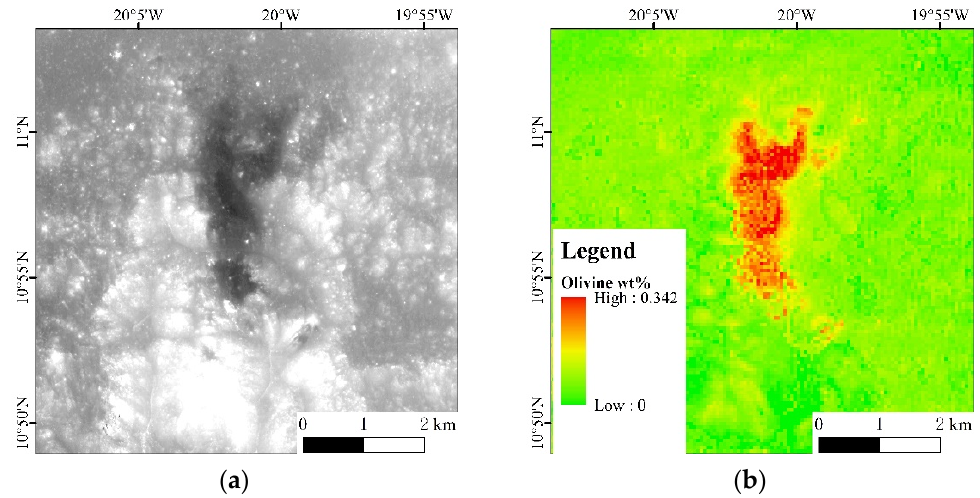
Figure 15. Olivine-bearing exposure in the northern wall of Copernicus. ( a ) Olivine-bearing exposure shown on the CE2 DOM G122; ( b ) Olivine map of the exposure.